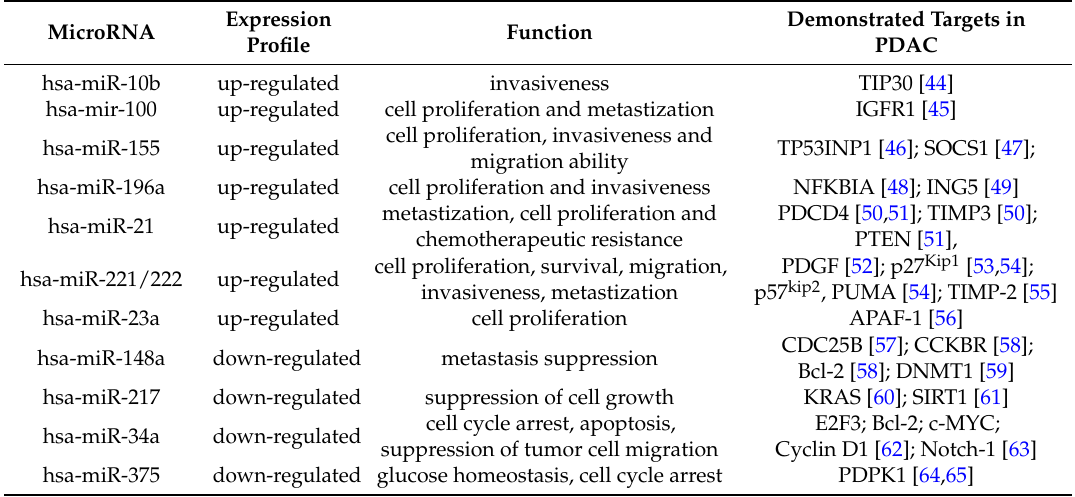
Table 2. Most frequently deregulated microRNAs in